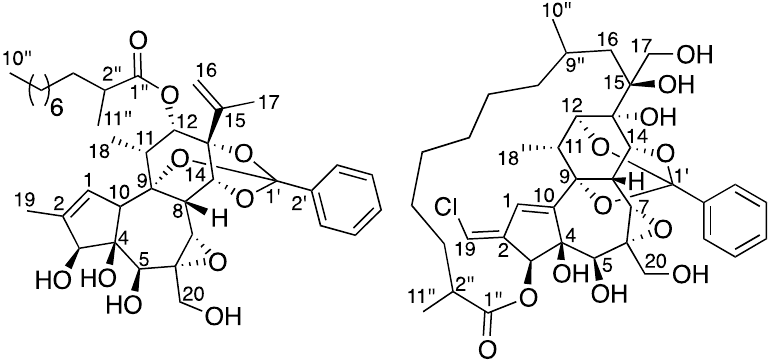
Figure 1. Structures of trigocherrierin A ( 1 ) and trigocheriolide E ( 2